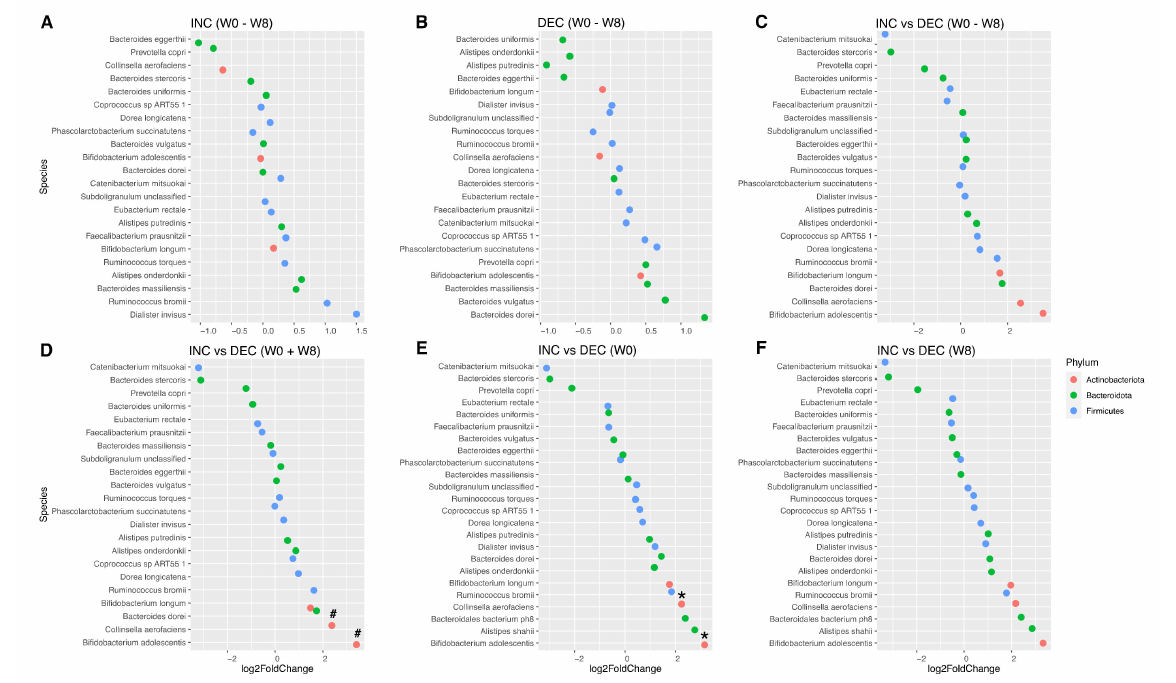
Figure 3. Differential abundance of fecal microbiota according to TMAO subgroups at the species level. Each bacterial species is represented by a point, and each color represents a different phy- lum. ( A , B ). Change in the abundance of bacterial species between weeks 0 and 8 in INC and DEC subgroups. ( C ). Differential change in the abundance of bacterial species between INC and DEC subgroups during the intervention. ( D ). Change in the abundance of bacterial species between CT and Rb groups, irrespective of the time. ( E , F ). Change in the abundance of bacterial species between CT and Rb groups at weeks 0 and 8, respectively. DEC and INC stand for TMAO decrease and increase subgroups, respectively. W0 and W8 stand for week 0 (baseline) and week 8 (end of the intervention). Asterisks and hashtags stand for significant differences between INC and DEC subgroups at nominal p -value < 0.05 and FDR-adjusted p -value < 0.05,